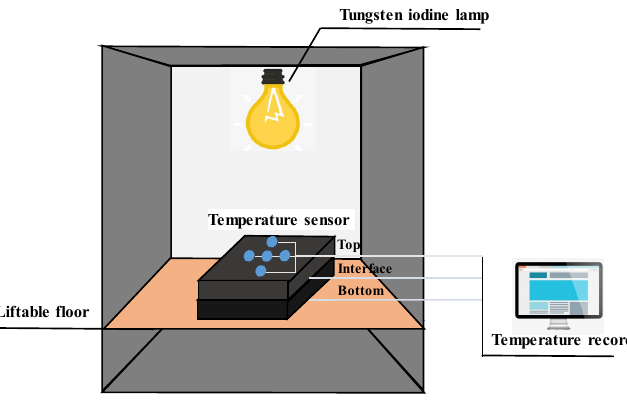
Figure 5. Schematic diagram of sunshine simulator.